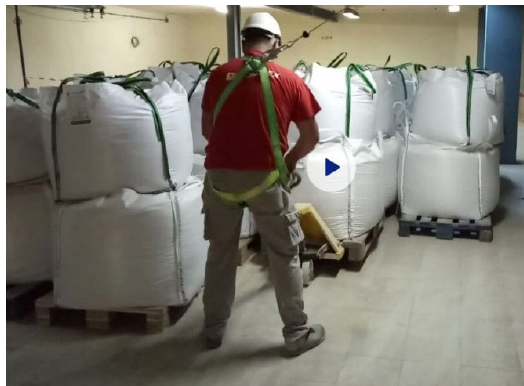
Figure 9. Process of loading and unloading (up to seven cycles in a week).